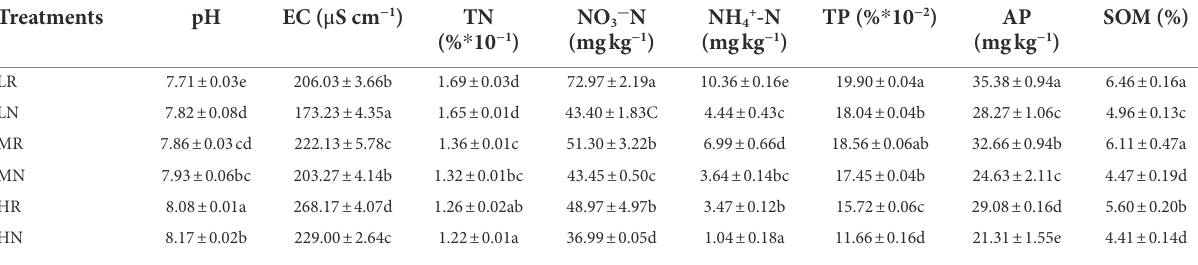
TABLE 1 Changes of soil physical and chemical parameters in different plots.